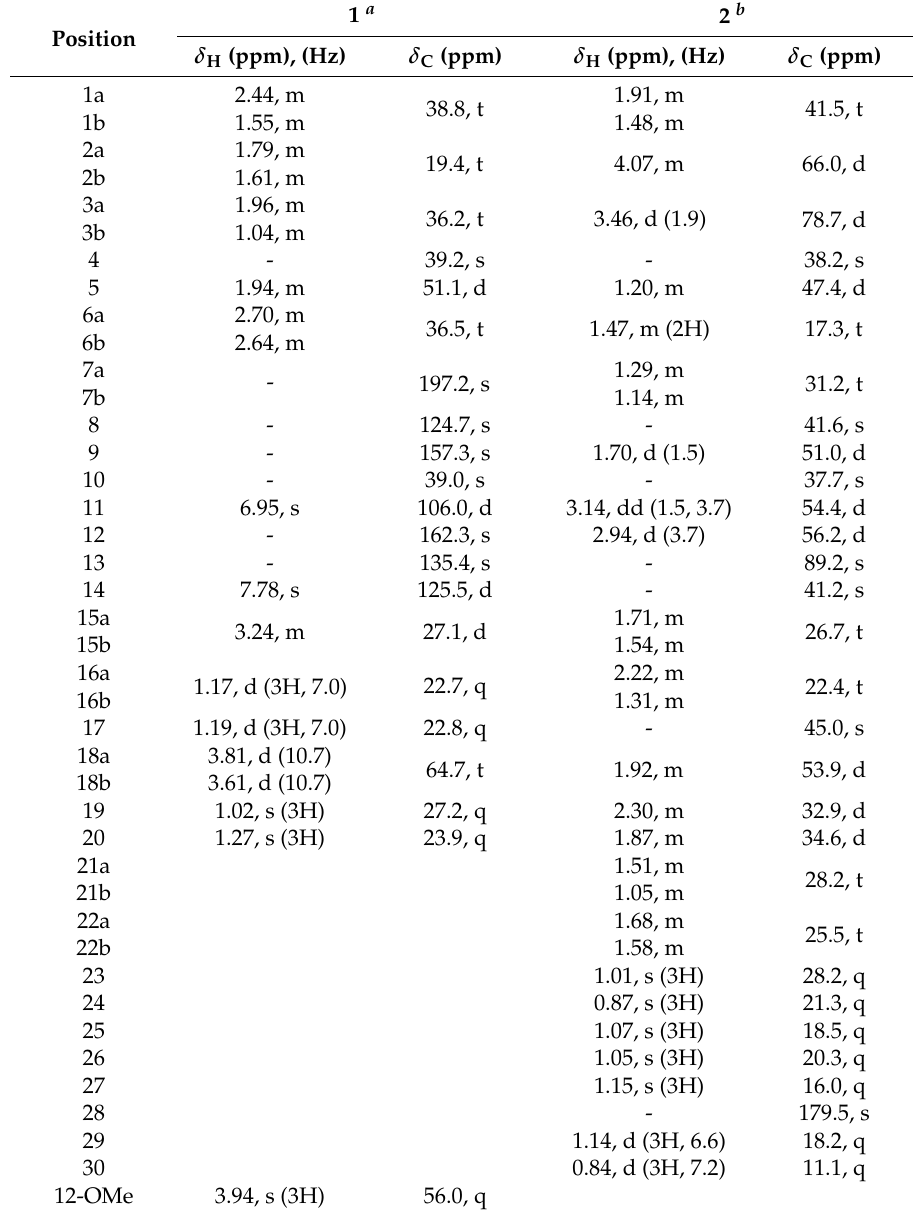
Table 1. 1 H (600 MHz) and 13 C (150 MHz) NMR spectral data of compounds 1 and 2